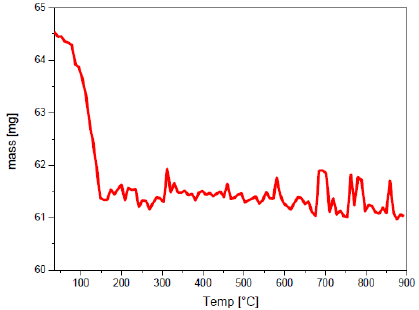
Figure 4. Thermogravimetric analysis curve for KNbW from 35 °C to 900 °C, in air, with heating rate of 10 K·min −1 . A total weight loss of 4.9(4)% is observed, corresponding to one water molecule per pyrochlore formula. Upon cooling the initial weight is recovered in air atmosphere after some hours. As shown in Table 1, the position for K ions within the pyrochlore unit cell is rather different in KNbW with respect to the two other pyrochlores. Although we found K located at 32 e site ( x = 0.0083(7)), it is significantly closer to (0,0,0), yet clearly not occupying the 16 c special site. It is worth